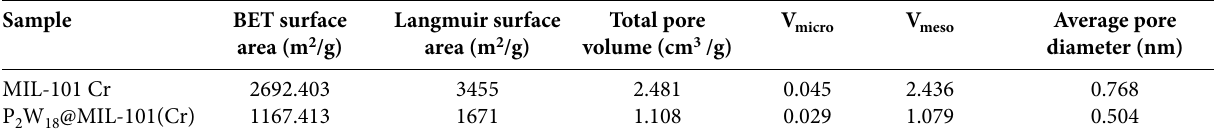
Table 1. The textural properties of MIL-101(Cr) and P 2 W 18 @MIL-101(Cr) samples.